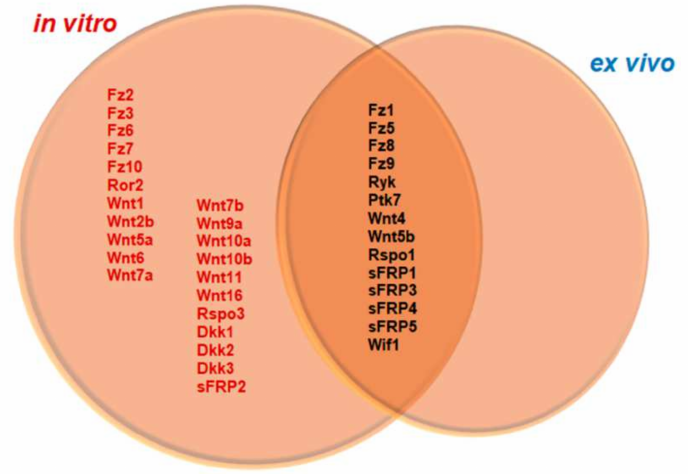
Figure 5. Differential gene expression of Wnt-related molecules among non-activated microglia in vitro and isolated microglia from uninjured spinal cord. Venn diagram shows Wnt-related genes that were detected both in vitro and ex vivo basal conditions. Text in red identify those genes exclusively detected in non-activated microglial cells in vitro, whereas the text in black identifies those genes that were detected in both non-activated cells in vitro and microglia cells that were isolated from uninjured spinal cord. There is no gene exclusively that was detected in the uninjured spinal cord